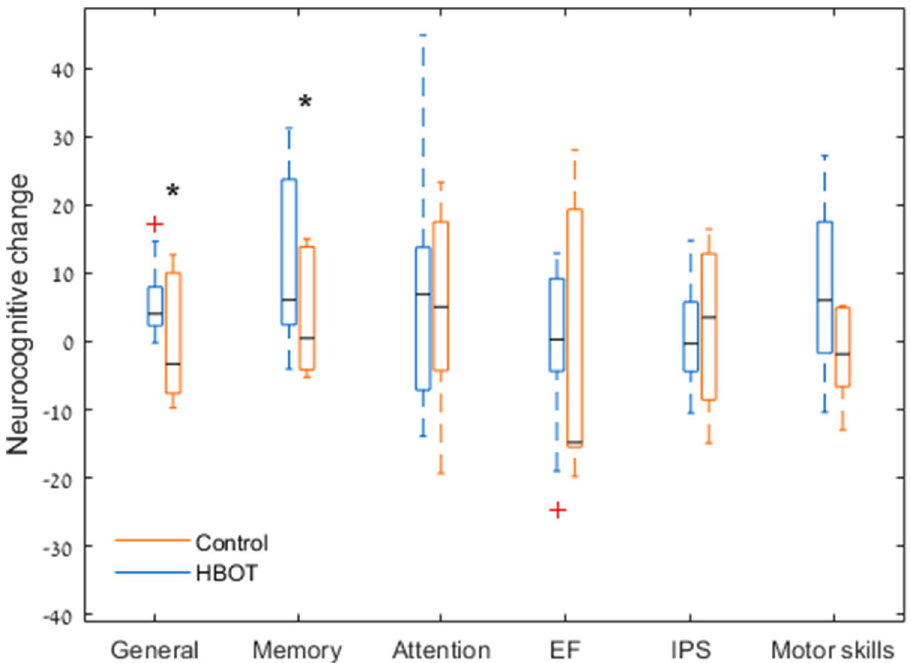
Figure 2. Primary endpoint changes boxplot. Both memory and the general cognitive scores were significantly increased after HBOT, with no changes in the sham group. Data shown as absolute mean change per cognitive domain. The central mark indicates the median, and the bottom and top edges of the box indicate the 25th and 75th percentiles, respectively. Red + symbols indicate outliers. *P <